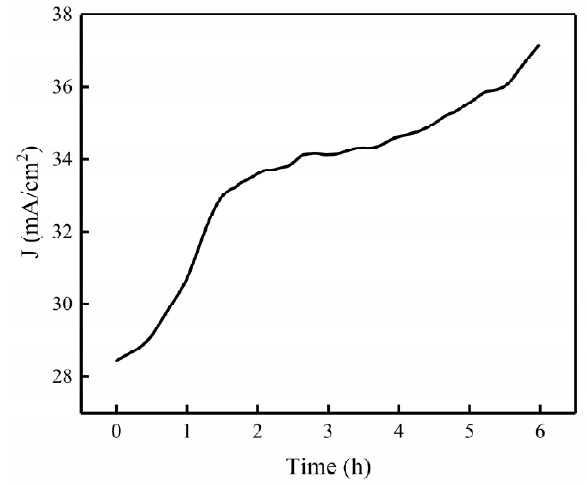
Fig. 7. Chronoamperometric curve of the electrode fabricated at 400 °C. The measurements were conducted in 1 M NaOH electrolyte and under the voltage of 0.65 V for 6